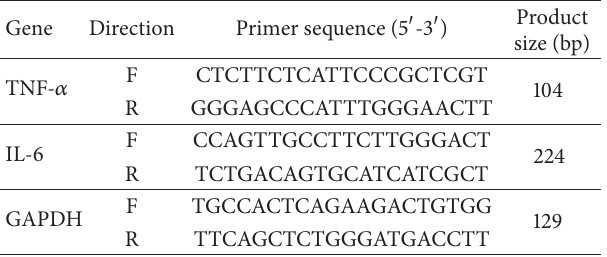
Table 1: Sequences of the primers used in this study.